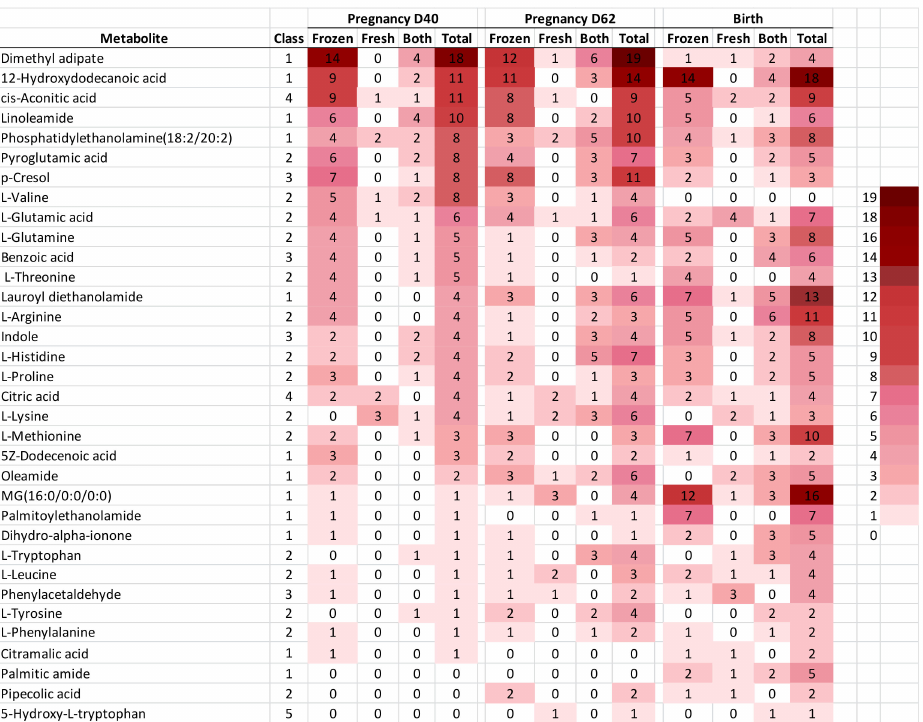
Figure 7. Heatmap representative of abundance of blocks within metabolites that predicted preg- nancy at the developmental endpoints D-40, D-62 (predictive blocks shown correspond to fresh and frozen, as well as non-cryopreservation dependent, embryos). The number of blocks per metabolite is ranked by the column “Total” within blocks at Pregnancy Day-40. Taxonomical classes (Class): (1) Lipids; (2) Amino acids; (3) Benzenoids; (4) Carboxylic acids; (5) Tryptamines and